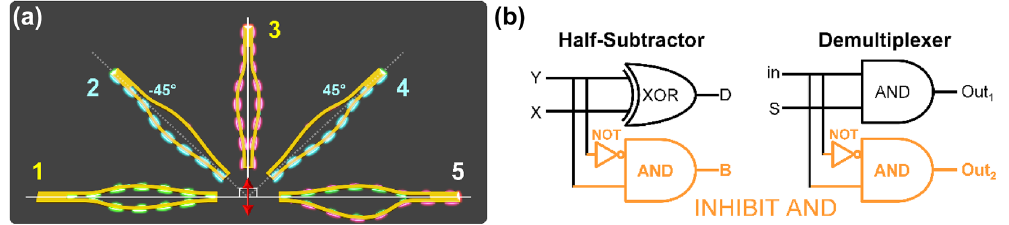
Figure 1: Device working principle. (a) Schematic illustration of the polarization-selective SPP modal properties of plasmonic TWTLs. The antisymmetric mode is labelled as case 1. Excitation of the symmetric mode is labelled as case 3. Conversion between the two modes can be achieved in case 5, by